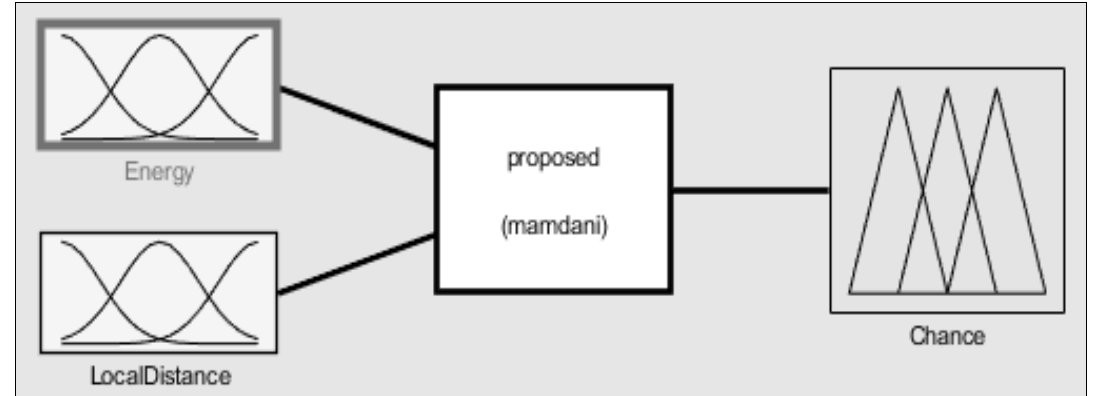
Figure 5. First FIS for cluster head (CH) selection.